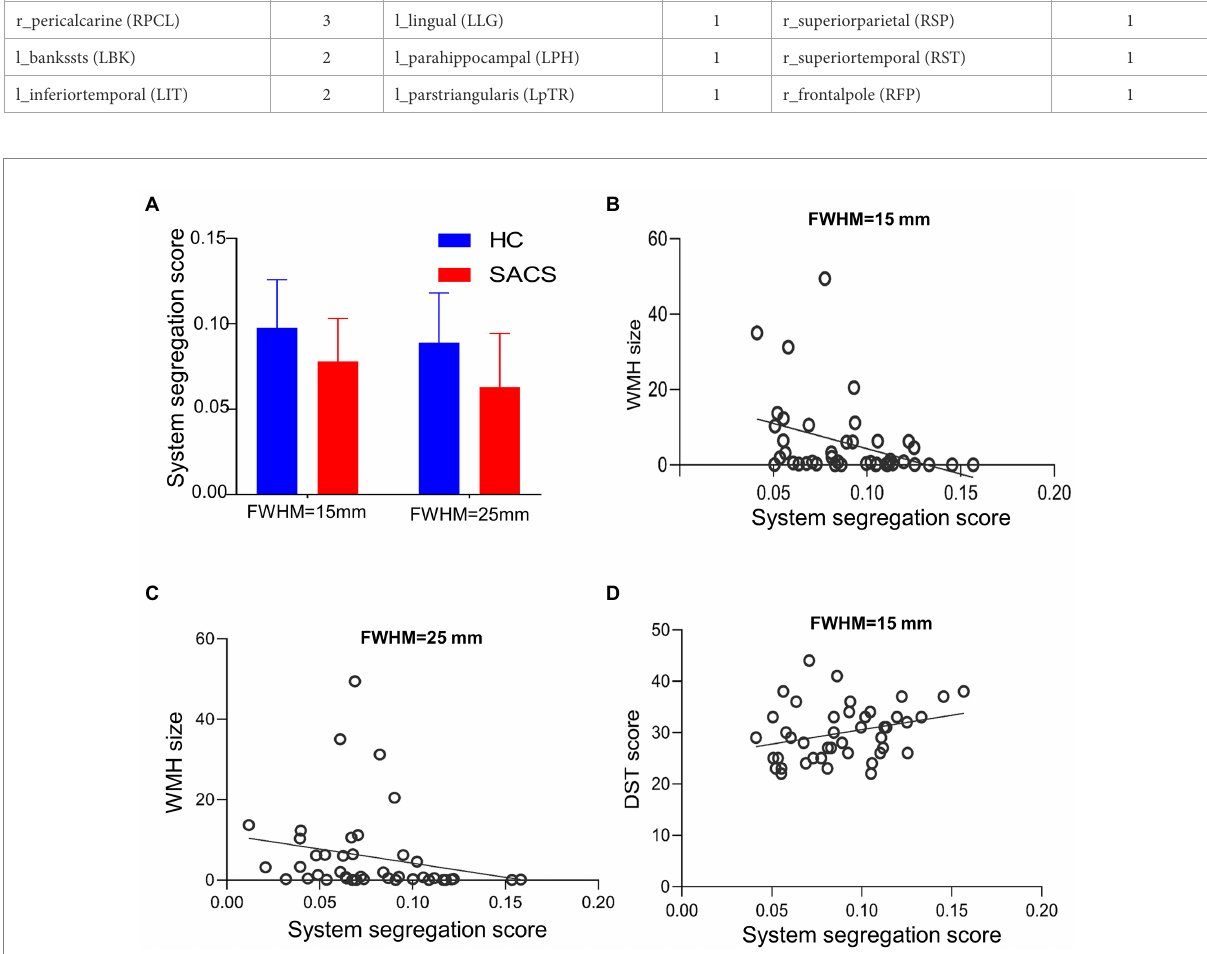
FIGURE 6 System segregation analysis. Between group comparisons on system segregation scores for the Desikan-Killiany atlas, both with FWMH 15 mm and 25 mm (A–D) . The SACS have significantly lower segregation scores, which are also correlated with the burden of white matter hyperintensity and cognitive tests.